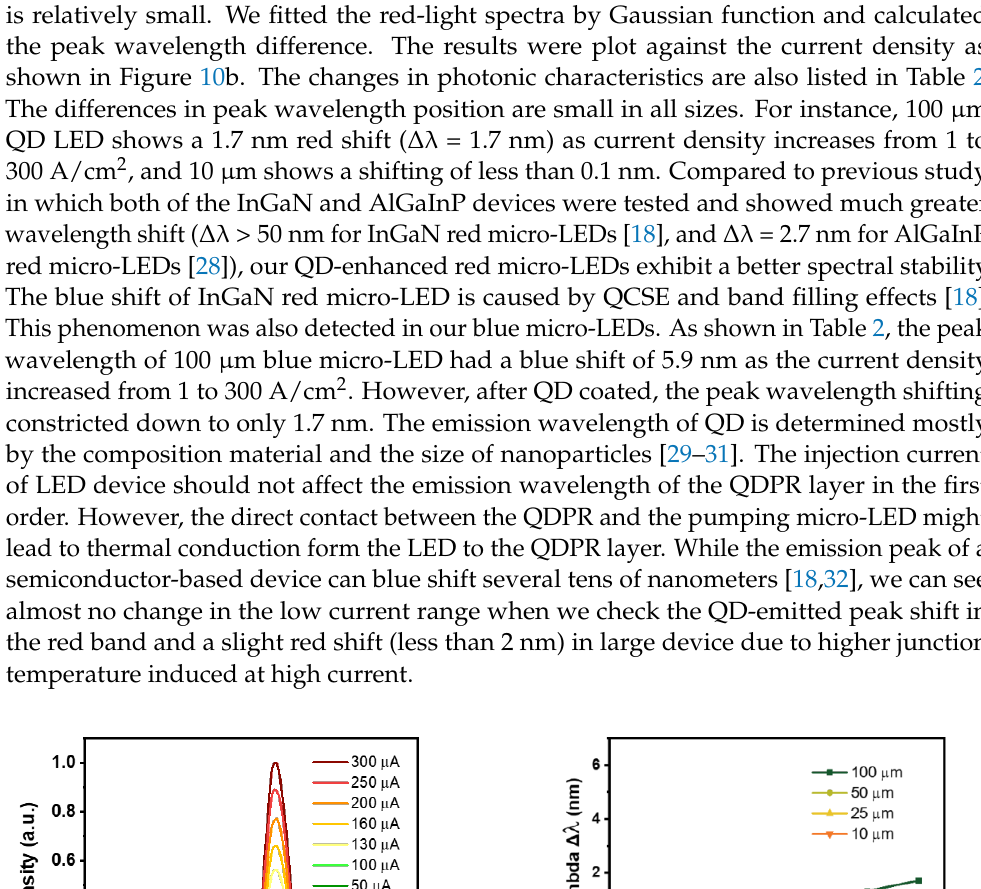
micro-LEDs (passivated by PECVD dielectric layers). The QD LEDs show clear superiority before